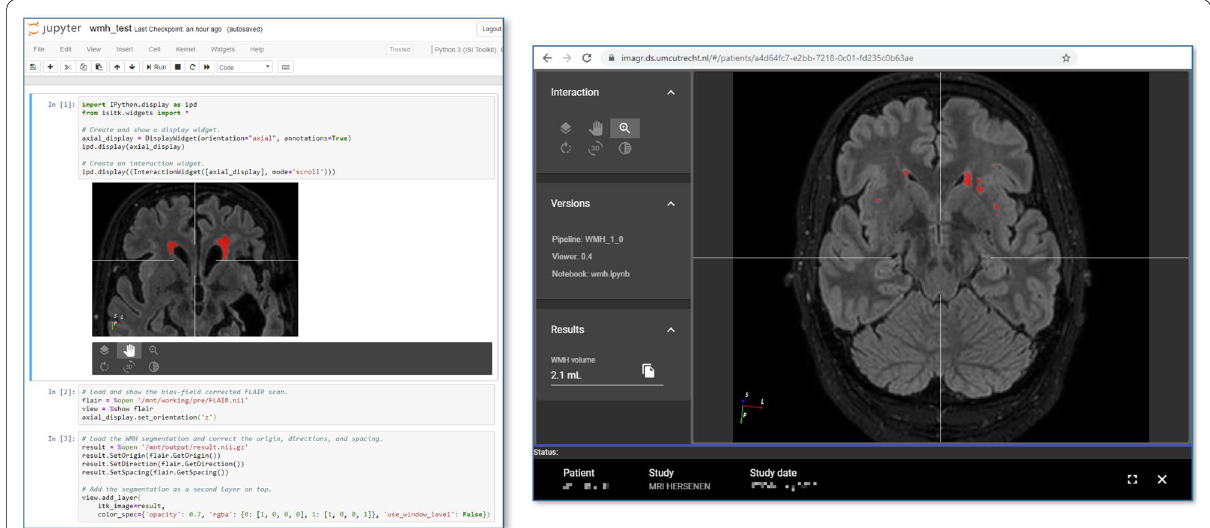
Fig. 3 Example of a Jupyter Notebook with widgets for highlighting white matter hyperintensities in the brain. Left panel shows the source code of several widgets underlying the visualization in the graphical user interface (GUI) as displayed in the right panel. GUI elements consist of visualizing the acquired image including the image overlay, a control panel for manipulation the image stack (scrolling, panning, rotation and zooming), an information panel showing the pipeline version number as well as the underlying Jupyter Notebook and a results